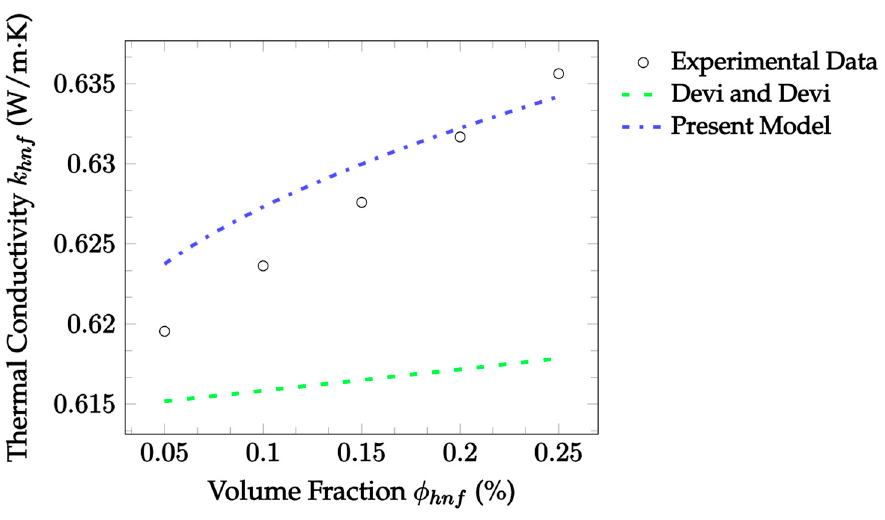
Figure 15. Present model predictions vs. best existing model for experimental findings of 50:50 TiO 2 –CaCO 3 /Water hybrid nanofluid: Experimental Data [87], Devi and Devi [38]. Table 7. Level of accuracy (%) of the best performing preexisting hybrid nanofluid model versus the present model. Dataset Devi and Devi